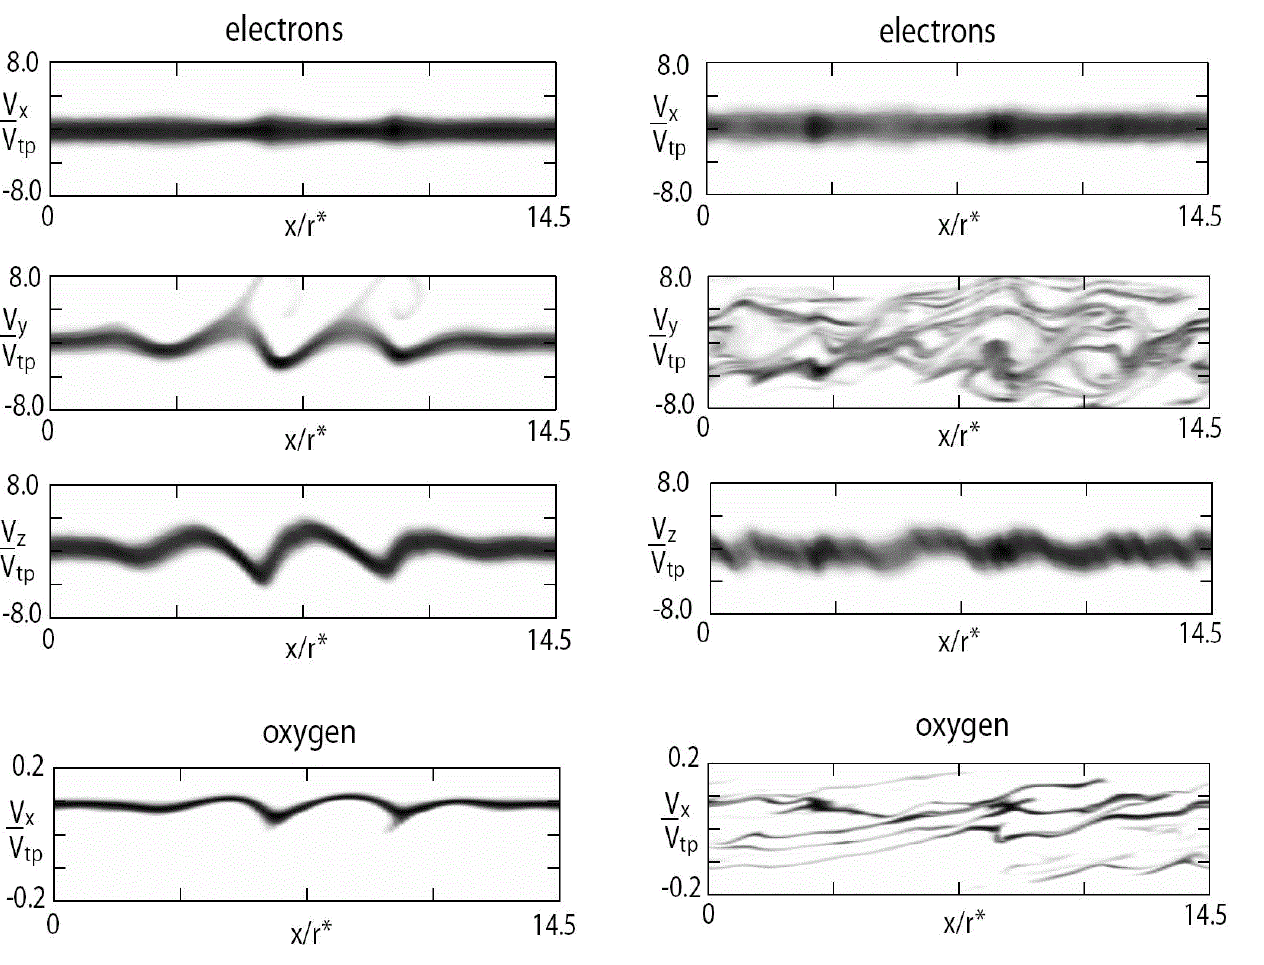
Fig. 5. Electron and ion phase space normalized to the initial pro- ton thermal velocity at the saturation of the linear stage of the PIC simulation.